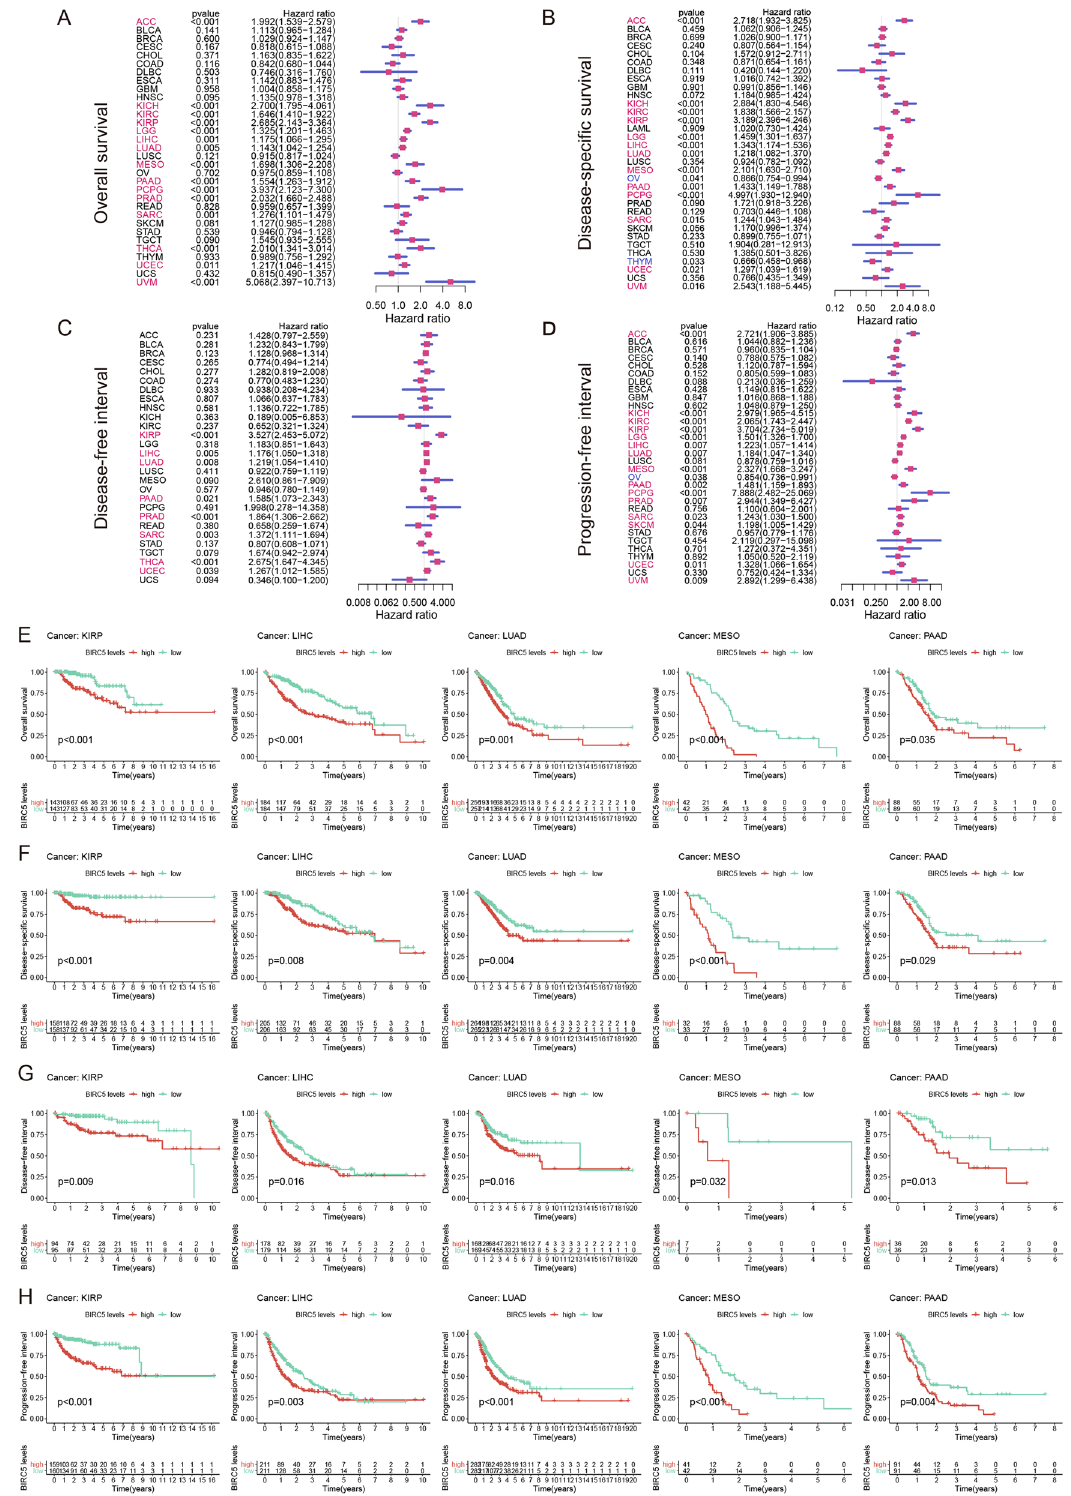
Figure 2. The relationship between the expression of BIRC5 and the prognosis of patients with 33 kinds of cancers in TCGA database. ( A ) Overall survival. ( B ) Disease-specific survival. ( C ) Disease-free interval. ( D ) Progression-free interval. Five kinds of tumors whose prognosis is most related to the difference of BIRC5 expression including ( E ) Overall survival, ( F ) Disease-specific survival, ( G ) Disease-free interval, ( H ) Progression-free interval . The figure was performed using R version 3.6.1 (2019-07-05) 46